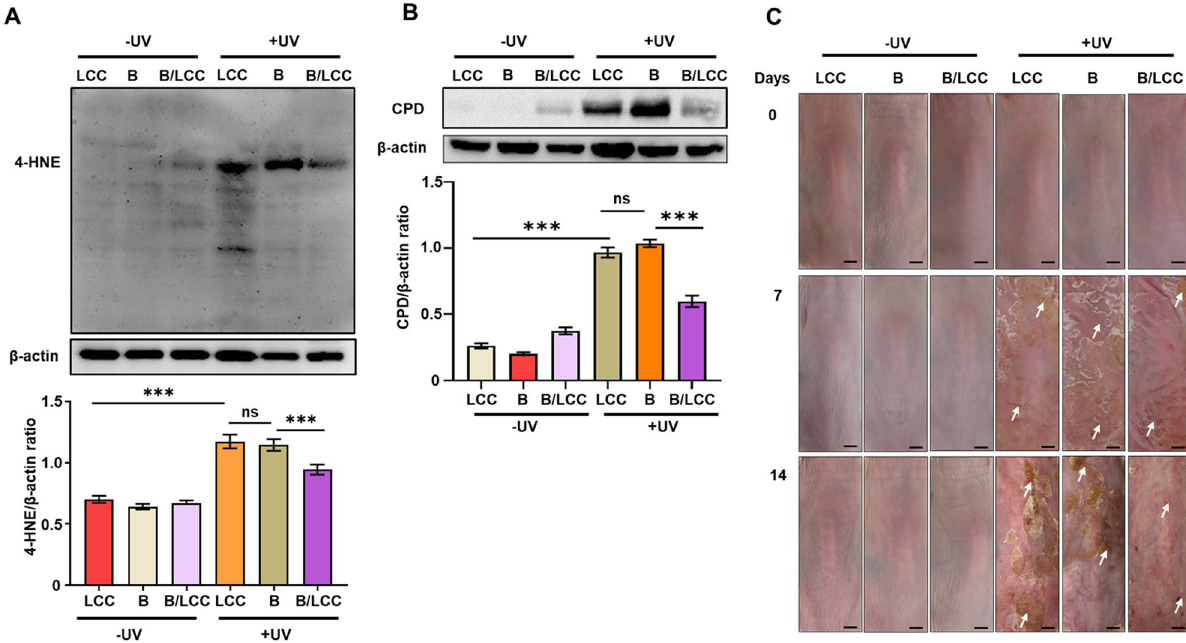
Figure 3. Effect of S. epidermidis in the presence of LCC on the UV-B-induced formation of 4-HNE, CPD and lesions. The dorsal skin of ICR mice topically applied with LCC alone, S. epidermidis ATCC 12228 alone ( B ), or S. epidermidis plus LCC (B/LCC) was irradiated with (+ UV) or without (− UV) UV-B. The images of protein bands of ( A ) 4-HNE or ( B ) CPD analyzed by western blot were displayed. The ratio of intensities of protein bands of 4-HNE or CPD normalized to β-actin was shown. ( C ) Morphologies of mouse skin irradiated with (+ UV) or without (− UV) 100 mJ/cm 2 UV-B 0, 7, and 14 days after irradiation were shown. Skin lesions were indicated by white arrows. Data are the mean ± SD from three independent experiments. *** P < 0.001 (two-tailed t-test). ns =